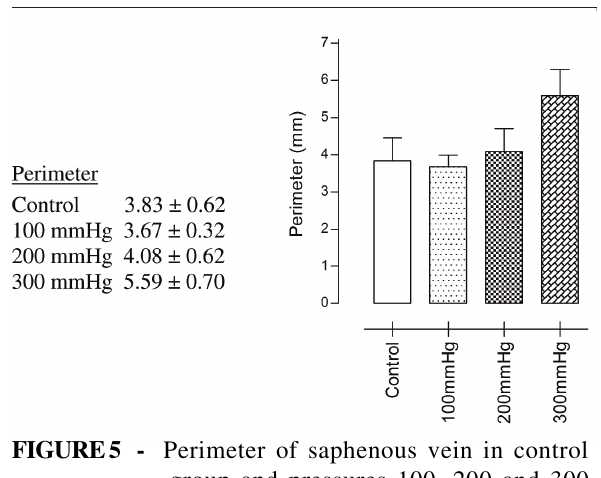
FIGURE 5 - Perimeter of saphenous vein in control group and pressures 100, 200 and 300 mmHg (n=20; ANOVA and Bonferroni post test, p > 0.05).